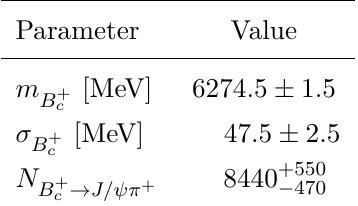
Table 2 . Parameters of the B + → J/ψπ + signal obtained with the unbinned extended maximum- c likelihood fit. Only the statistical uncertainties are included. No efficiency correction is applied to the signal yield.